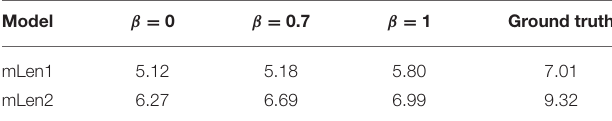
FIGURE 4 | The quality of semantic features predicted with different sets of input features evaluated by mAP on the MSR-VTT dataset.